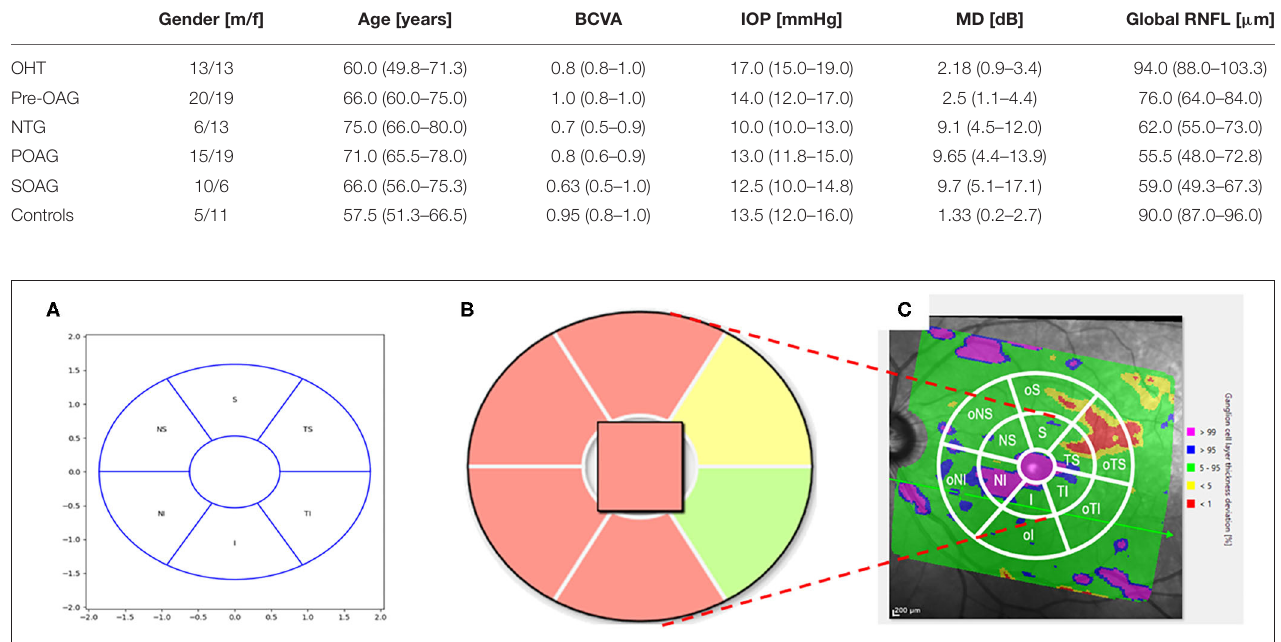
FIGURE 1 | Schematic scetch of the conventional macular grid (A) with color coding (B) and extended version (C) . (A) Conventional Macular Grid: The macular grid was defined by an elliptical ring: the inner radius was 0.618mm in the horizontal axis and the inner radius of the vertical axis was 0.531mm. The outer radius of the elliptical ring was 1.857mm horizontally and 1.590mm vertically. The elliptical ring was divided into 6 sectors with angles of 60 ◦ . These 6 sectors of the macular grid corresponded to the superior (S), inferior (I), temporal-superior (TS), temporal-inferior (TI), nasal-superior (NS), and nasal-inferior (NI) macular region. (B) Macular Grid color-coding: The sectors of the macular grid were color-coded according to percentiles: A sector is marked with green if the thickness of the RGCL in this sector is > 5th percentile of a healthy reference population. If a sector is colored yellow, the value of the average RGCL thickness < 5th percentile, yet > 1st percentile of the reference database. A red colored sector represented data which were < 1st percentile. In the qualitative analysis, a green sector was counted with one point, a yellow sector with 2 and a red sector with 3 points. (C) Extended Macular Grid: An enlarged elliptical ring was added to the pre-existing macular grid (extended macular grid): 3.714mm horizontally and 3.18mm vertically (i.e., doubled outer radii of the conventional macular grid, respectively). This resulted in 6 new outer sectors (o). The outer sectors were called outer superior (oS), outer inferior (oI), outer temporal-superior (oTS), outer temporal-inferior (oTI), outer nasal-superior (oNS), and outer nasal-inferior